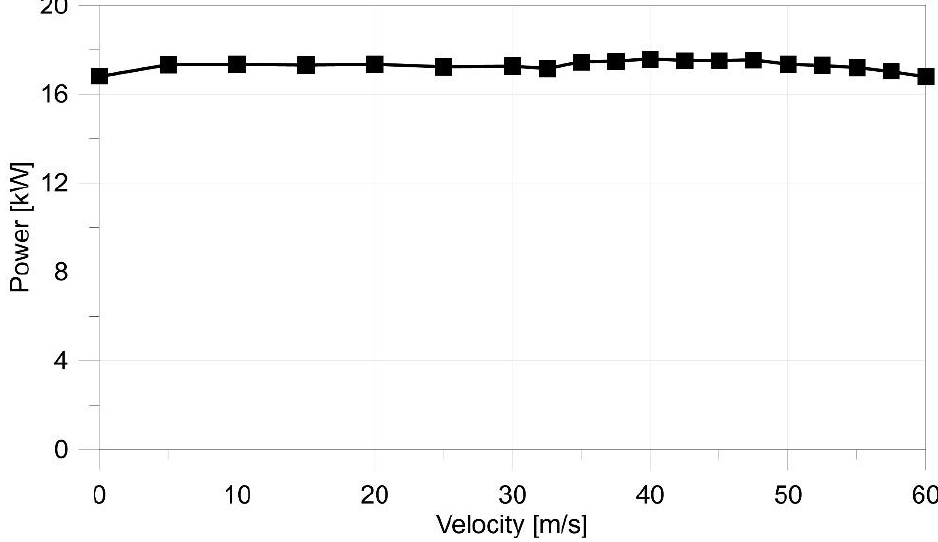
Figure 24. Power required for operating fans at Δ p = 3000 Pa.